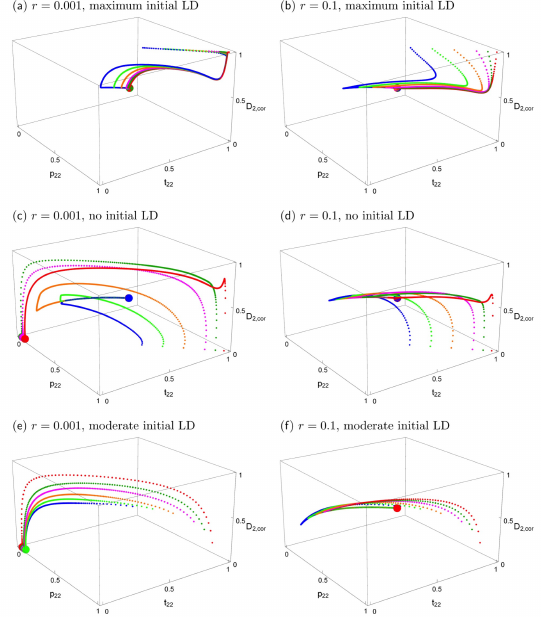
Figure 5. The effects of initial conditions and recombination rates on evolutionary trajectories when the trait is expressed only in males. This figure is analogous to Figure 3 with the sole difference that here the trait is expressed only in males. The fully polymorphic equilibrium is the same in all panels. It is symmetric and given by p 2,2 = 1 − p 2,1 = 0.526, t 2,2 = 1 − t 2,1 = 0.549, D 2 = D 1 = 0.1316. Convergence to the polymorphic equilibrium is typically very slow. If r = 0.001 (left column), convergence occurs after about 500,000–1 million generations; if r = 0.1 (right column), it occurs after about 10,000–50,000 generations. Loss of the trait and preference alleles occurs on a much shorter time scale, on the order of 100–2000 generations. ( a , b ) maximum initial linkage disequilibrium (D 2,cor = 1); ( c , d ) and no initial linkage disequilibrium (D 2,cor = 0); ( e , f ), the initial values of the preference allele and the linkage disequilibrium are taken from the curve of stable equilibria that exists in allopatry (see main